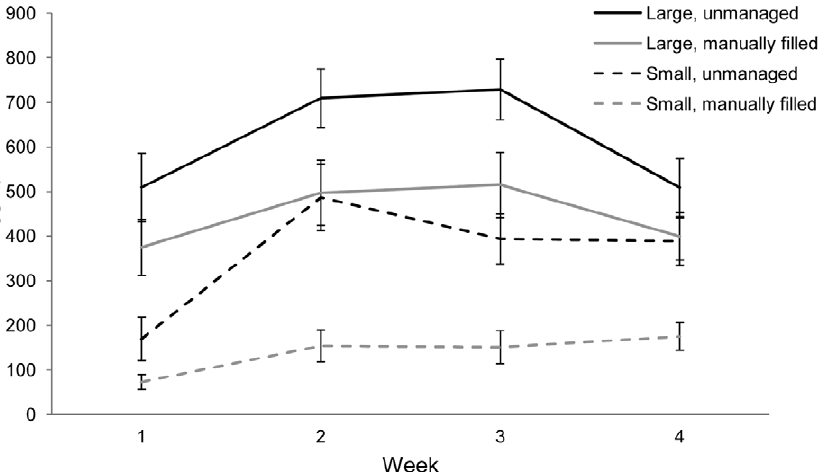
Figure 4. Oviposition by container type. Mean ( 6 SE) number of eggs laid by Ae. aegypti in four container treatments in Iquitos, Peru (80 containers located in 20 houses). Daily egg counts for each container were summed over each week and divided by container